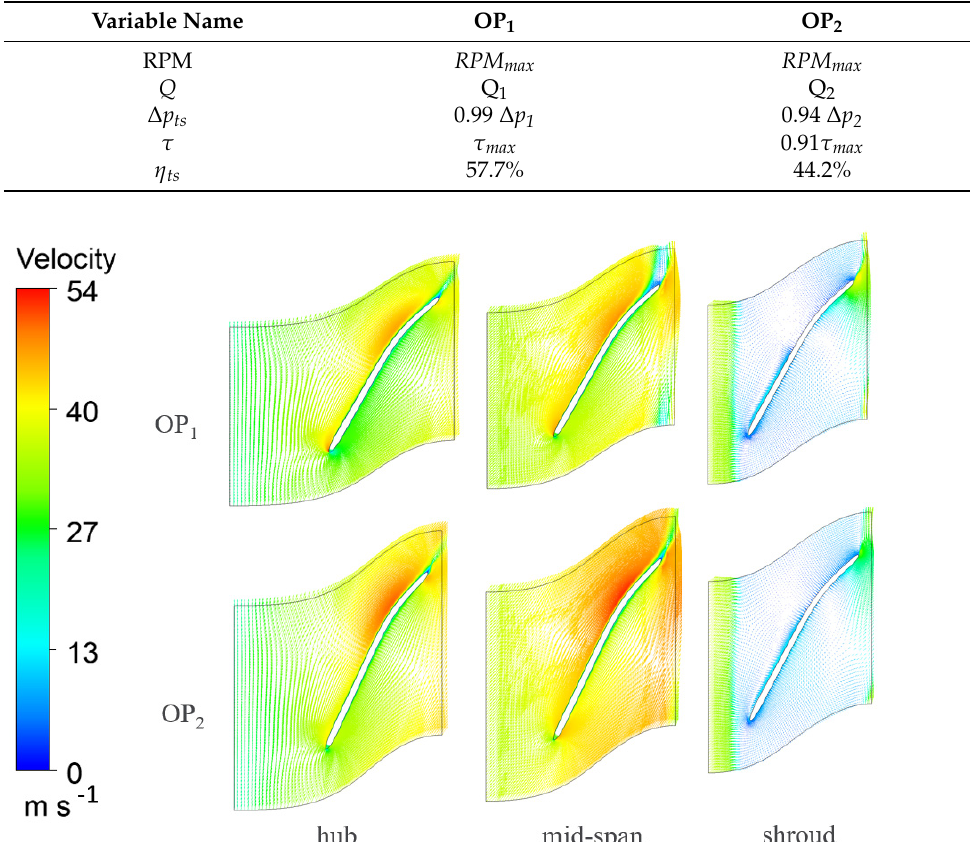
Table 2. Baseline CFD results.